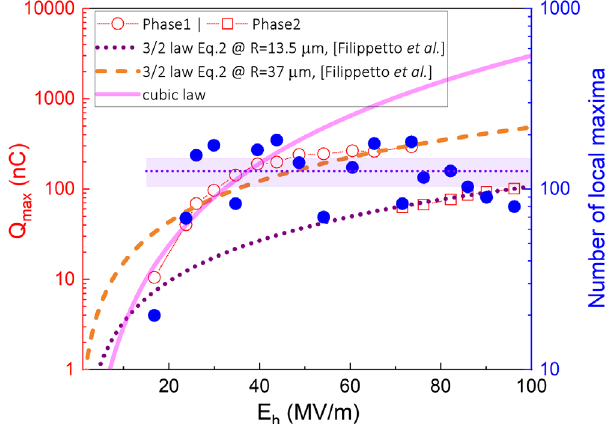
FIG. 8. Maximum charge and the number of emitters deter- mined at the maximum of every conditioning QvsE curve as functions of E h . The purple horizontal area represents one standard deviation around the mean value of the emitter number count. plot as it would be expected to based on the series resistor model. This confirms the leading role of the electric field effects outside (and not inside) the cathode. Figure 8 sums up this representation by illustrating that the charge dynamics are driven by the electric field and not the emitter statistics (given the charge drift trans- port in UNCD bulk must be considered saturated at all gradients [36]). To further elaborate on these conclusions, we utilize two-dimensional (2D) space charge formalism developed by Filippetto et al . elsewhere [39]. Having a field emission period of 38 ps in L -band, the generated beam can be termed as the cigar aspect ratio beam.